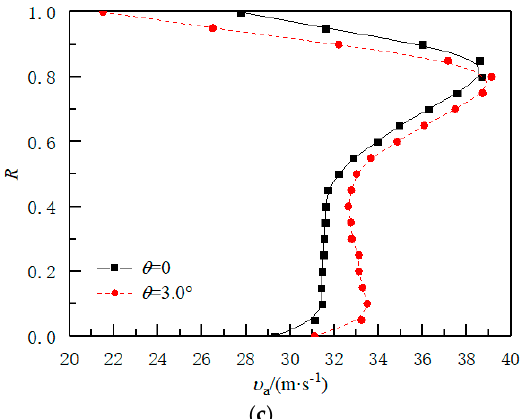
Figure 8. Distribution of the axial velocity along the blade height. ( a ) β = 29° and Q v = 34.98 m 3 ·s ‒ 1 ; ( b ) β = 32° and Q v = 37.14 m 3 ·s ‒ 1 ; ( c ) β = 35°and Q v = 41.64 m 3 ·s ‒ 1 .